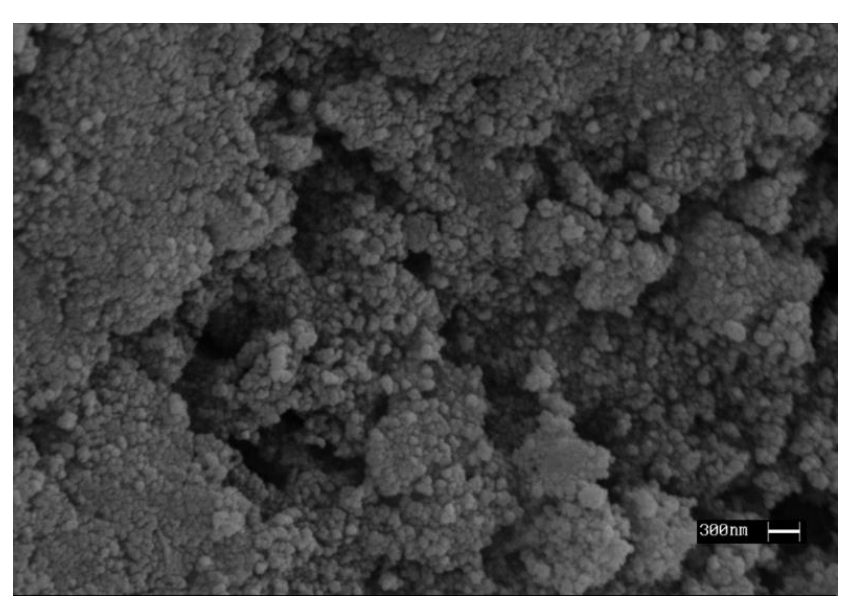
Figure 2. Morphological SEM characterization of MDSCNs (scale: 300 nm).